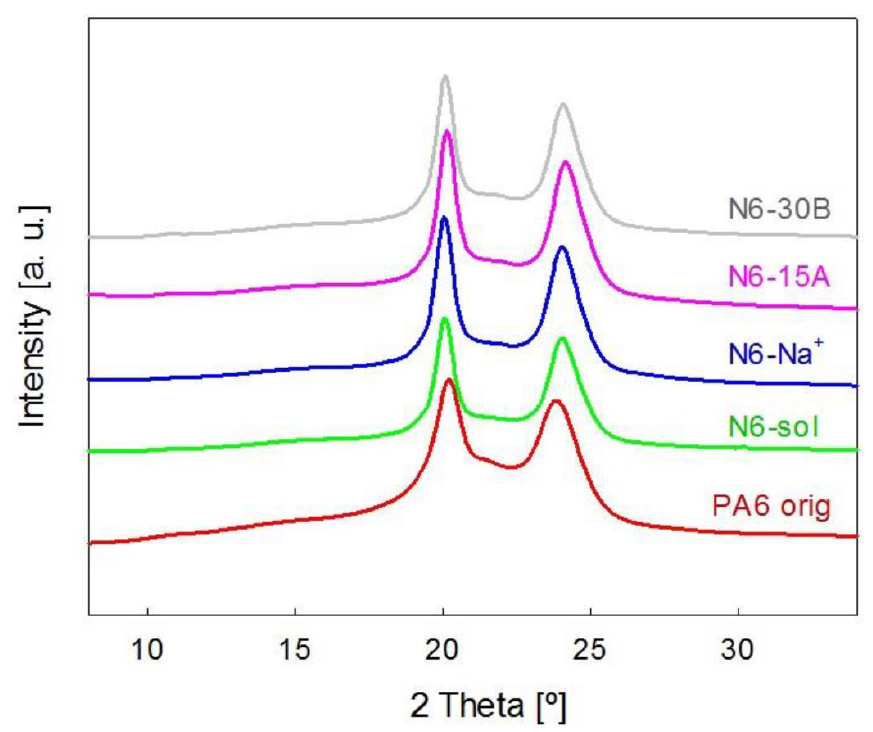
Figure 4. WAXS patterns of as-received and solution compounded nylon6, together with the solution compounded composites.